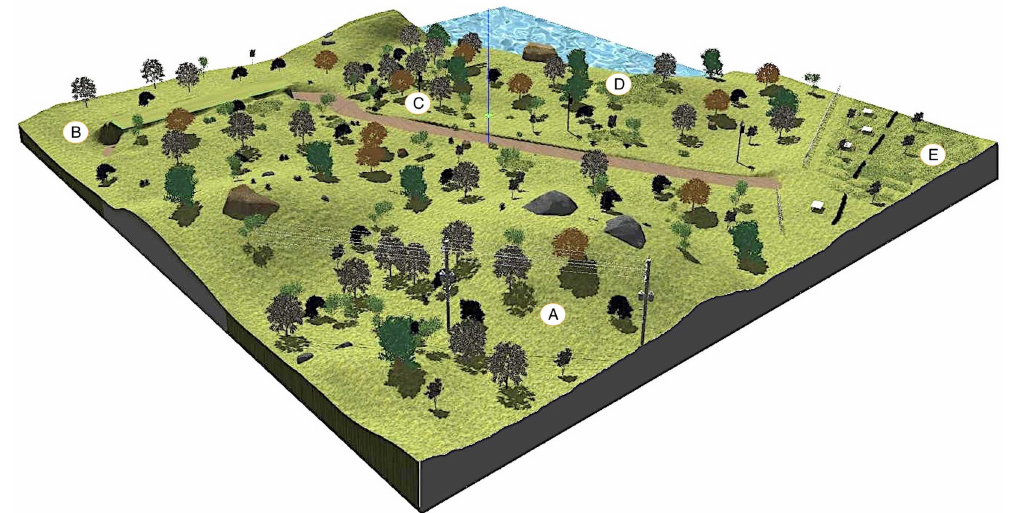
Figure 2. Overview of the natural environment built with Gazebo. Five different zones are marked with capital